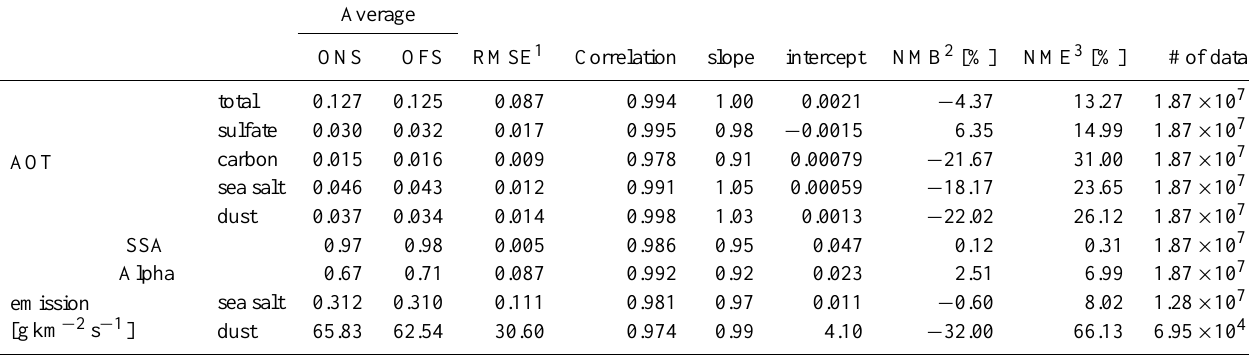
Table 1. Statistical results of the offline model (OFS) versus the online model (ONS) for aerosol optical thickness (AOT) and emissions. All statistics were calculated between 70 ◦ S and 70 ◦ N. Average ONS OFS RMSE 1 Correlation slope intercept NMB 2 [%] NME 3 [%] # of data total AOT